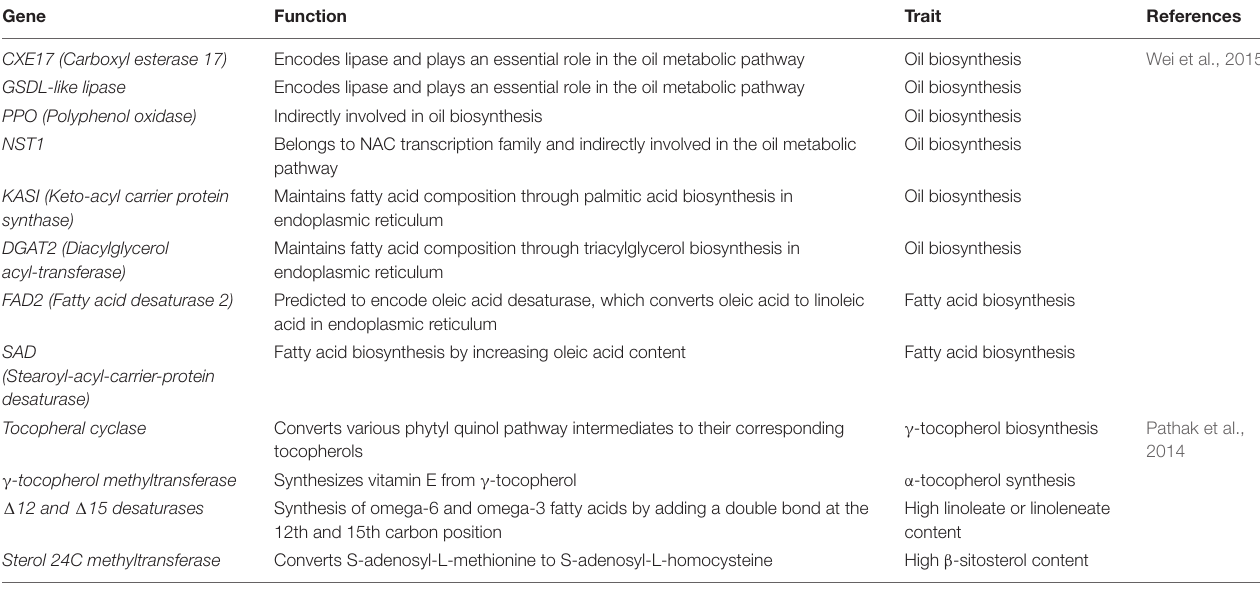
TABLE 3 | Genes for oil-related contents in sesame.